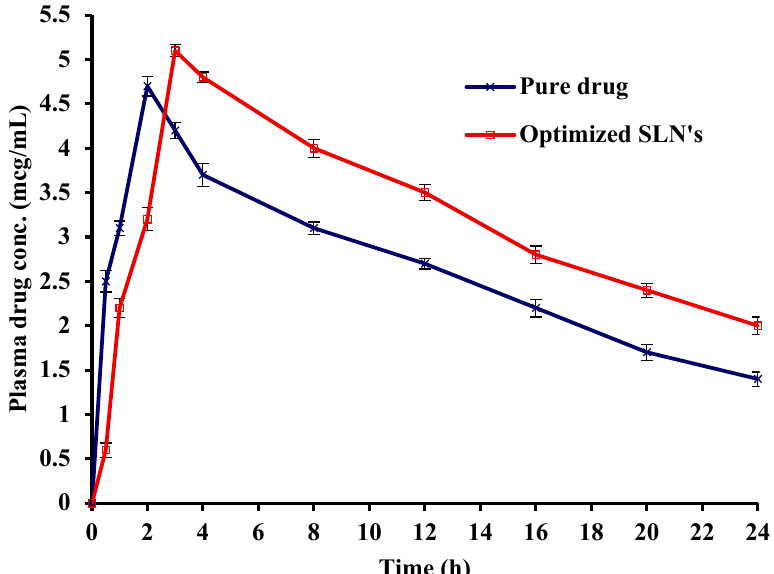
Figure 9. Plasma drug level profile of pure drug and optimizes SLN’s formulation.